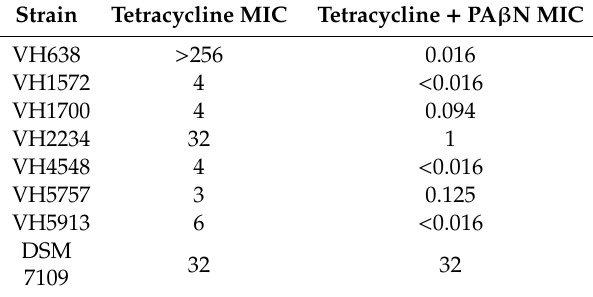
Table 3. MIC values (mg/L) of seven C. urealyticum and the reference strain DSM 7109 determined in absence and presence of PA β N.